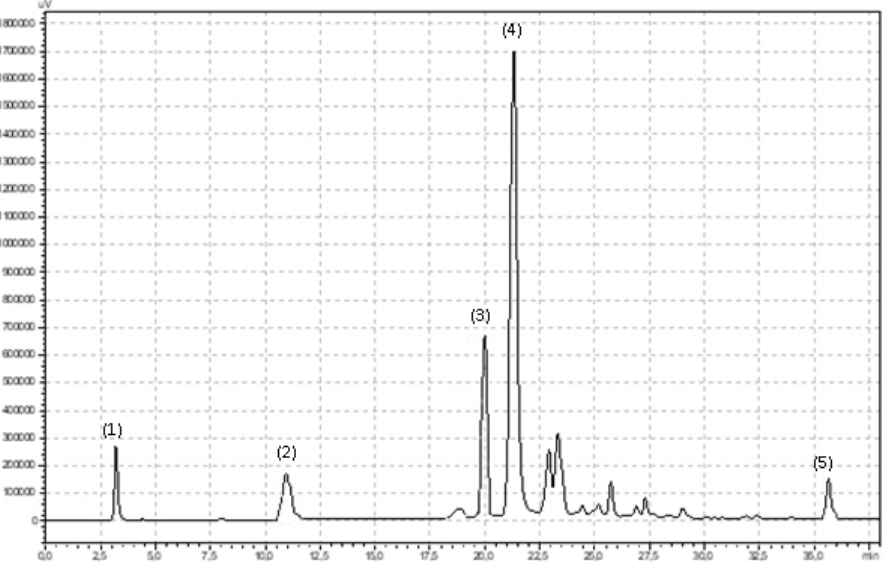
Figure 5. Chromatogram showing retention times for phenolic acids in fireweed leaves: ( 1 ) gallic, ( 2 ) chlorogenic, ( 3 ) p-coumaric ( 4 ) benzoic, ( 5 )